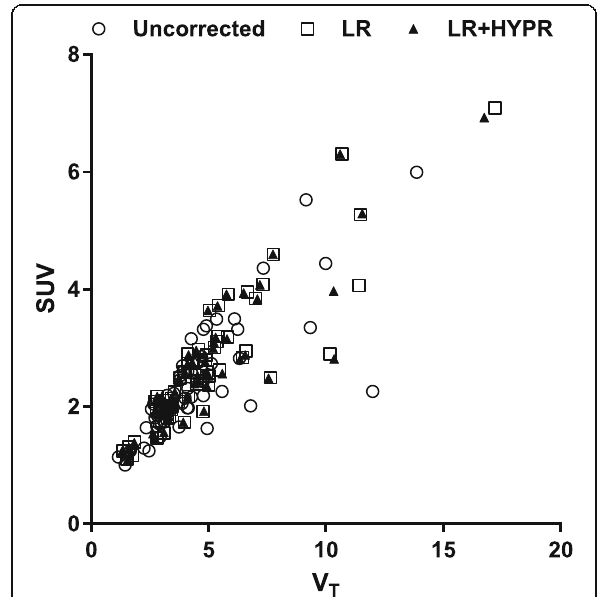
Fig. 4 Scatter plot of V T versus SUV, without and with PVC. For both LR and LR + HYPR, the Spearman correlation between V T and SUV increased from 0.82 to 0.90 after PVC